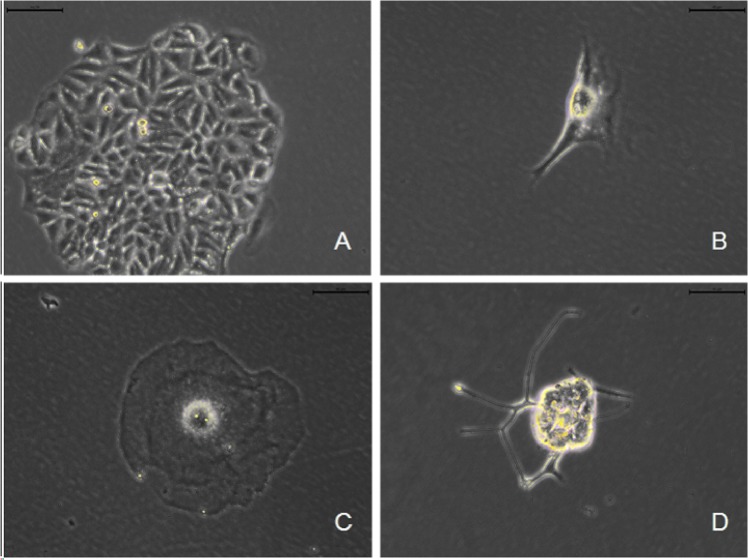

137Cs gamma-ray irradiation induces death in HepG2 cells in vitro.After 0 (A), 30 (B), 50 (C) and 100 (D) Gy 137Cs gamma-ray irradiation, HepG2 cells separated from human erythrocytes were cultured for 7 d, and then their morphology (scale bar: 40 μm) was observed.